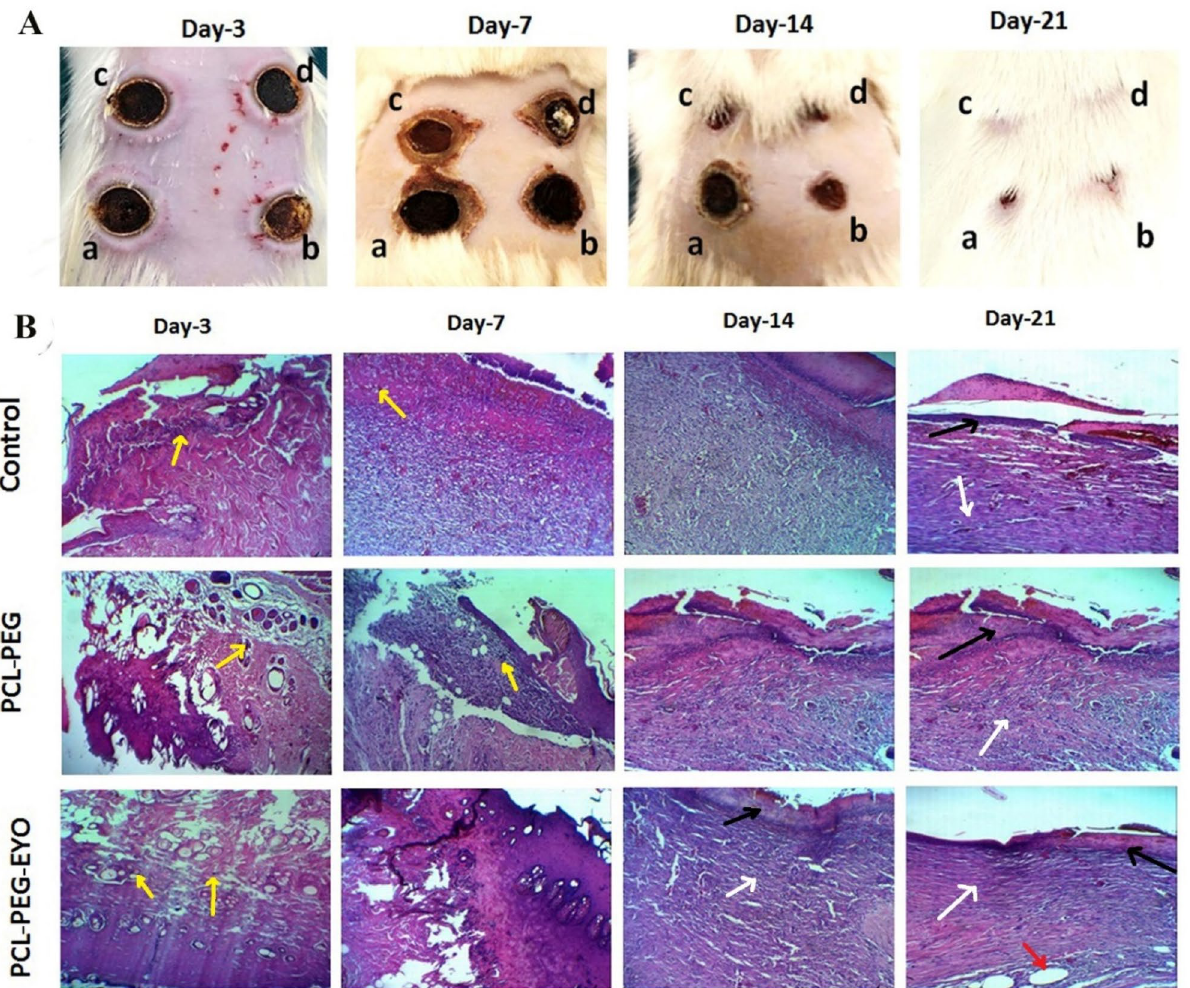
Figure 5. ( A ) Macroscopic investigation of wound healing process in different wounds treated with: (a) no scaffolds (control), (b) PCL-PEG nanofibrous scaffold, c and d) PCL-PEG-EYO nanofibrous scaffolds; through digital imaging at time points of 3, 7, 14 and 21 days post operating; ( B ) H&E histology images (100x) of wound tissue in control group, PCL-PEG and PCL-PEG-EYO nanofibrous scaffold. (Yellow arrows: PMNs; white arrows: collagen formation; black arrows: new epithelium; red arrows: skin appendages).